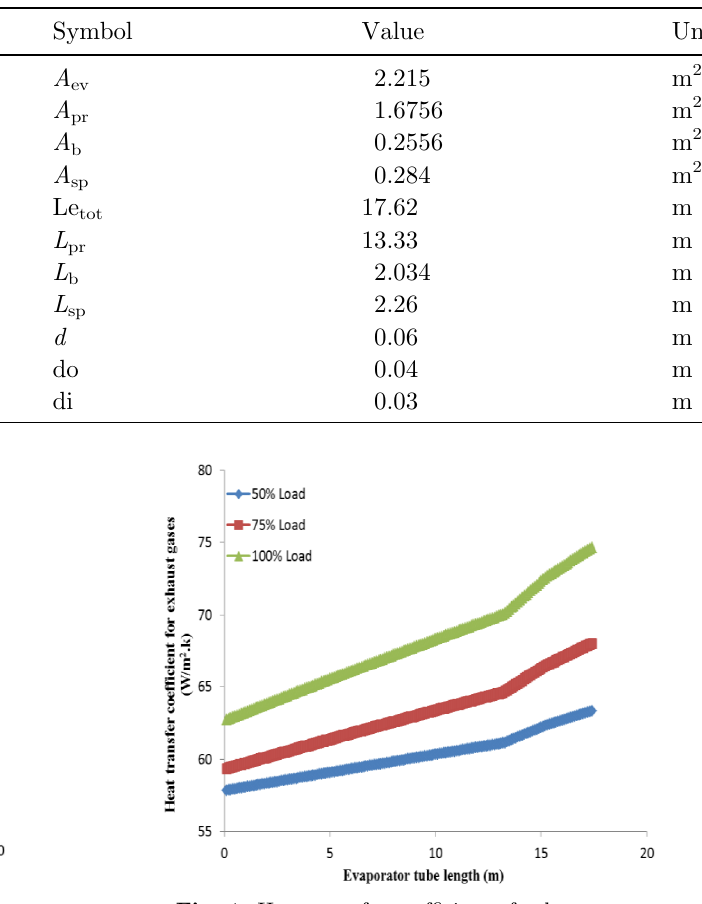
Table 1. Evaporator model parameters from design [8].